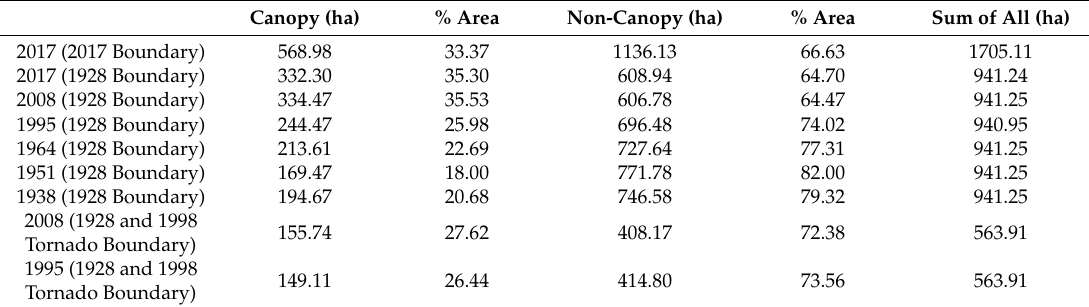
Table 7. OBIA canopy change